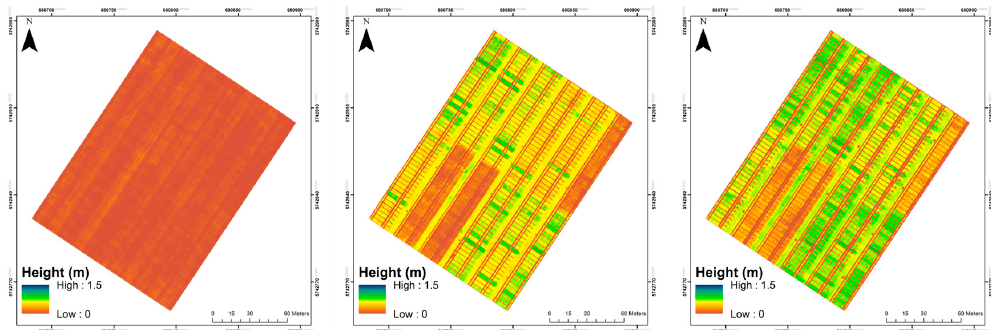
Figure 13. Normalised Digital Surface Models (nDSM) for three different wheat development stages captured on the 14 April 2015, 4 June 2015 and 6 July 2015 respectively. Clearly visible in the middle and right-hand figures are the 0 Kg·hectare − 1 nitrogen treatment strips where crop height has been noticeably stunted compared to surrounding plots. Coordinates are displayed in WGS 1984 Coordinate System.